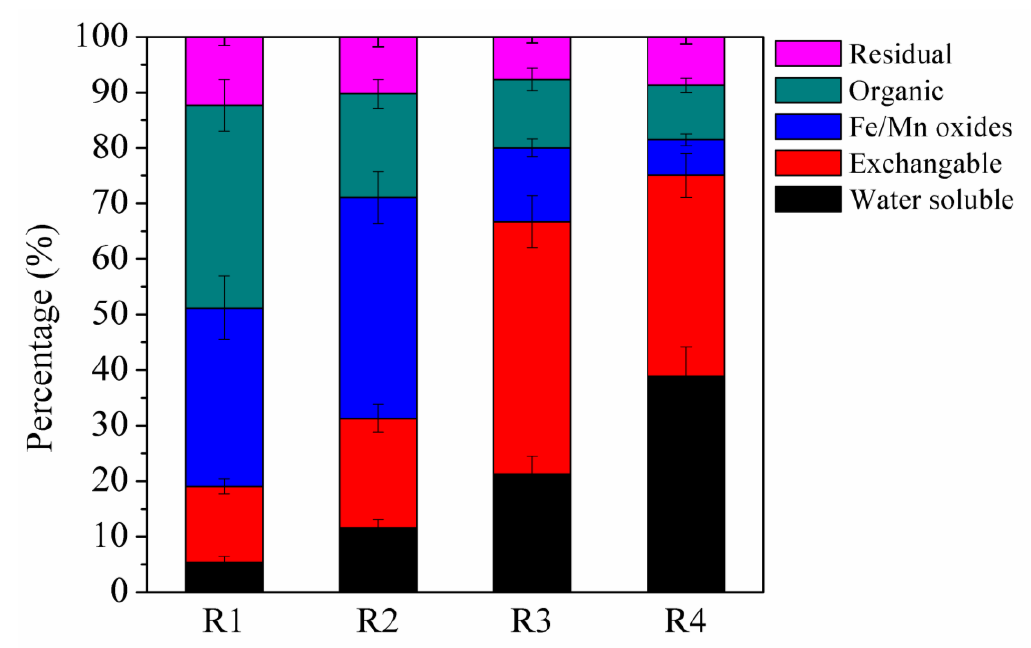
Figure 3. Distribution of different Ni fractions in the R1 – R4 on the 20th day.